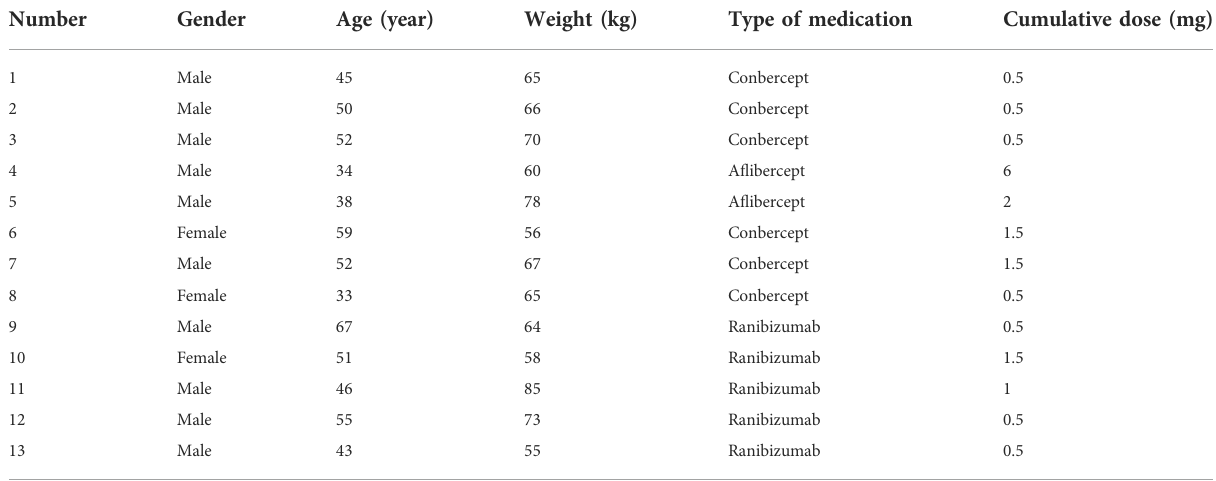
TABLE 3 The VEGFi medication information of